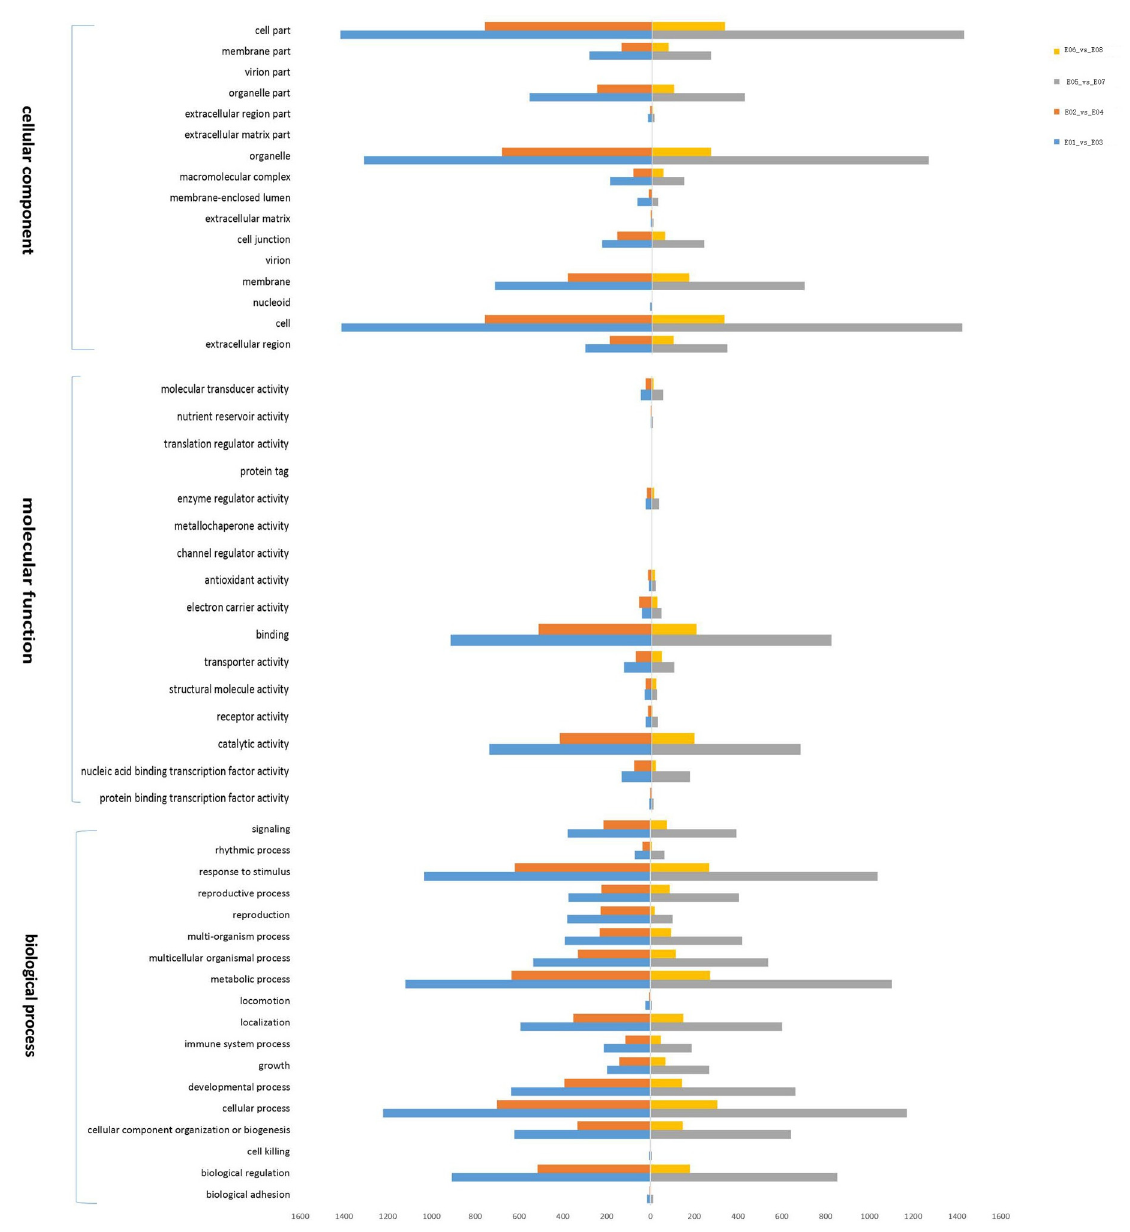
Fig 6. Gene Ontology (GO) functional annotation of differentially expressed genes based on RNA-Seq data in E01 vs E03 (blue), E02 vs E04 (dark red), E05 vs E07 (purple) and E06 vs E08 (yellow). The three main categories (biological process, cellular component, and molecular function) were used for GO